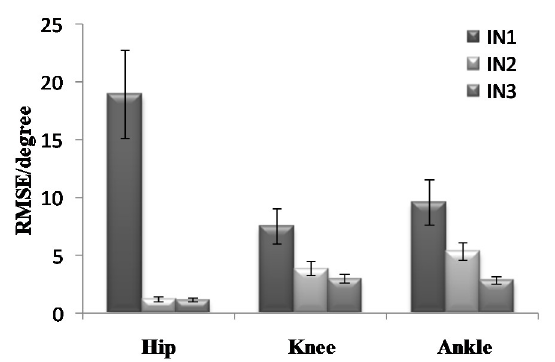
Figure 20. RMSE of the prediction results in the going upstairs process.